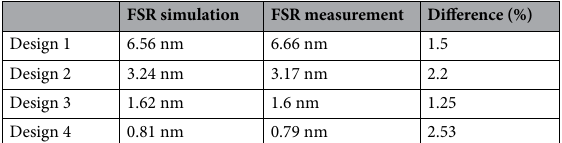
Table 3. Calculated FSR from simulations and measurements near 1.55 µm of the four different LT-aMZI designs and the difference